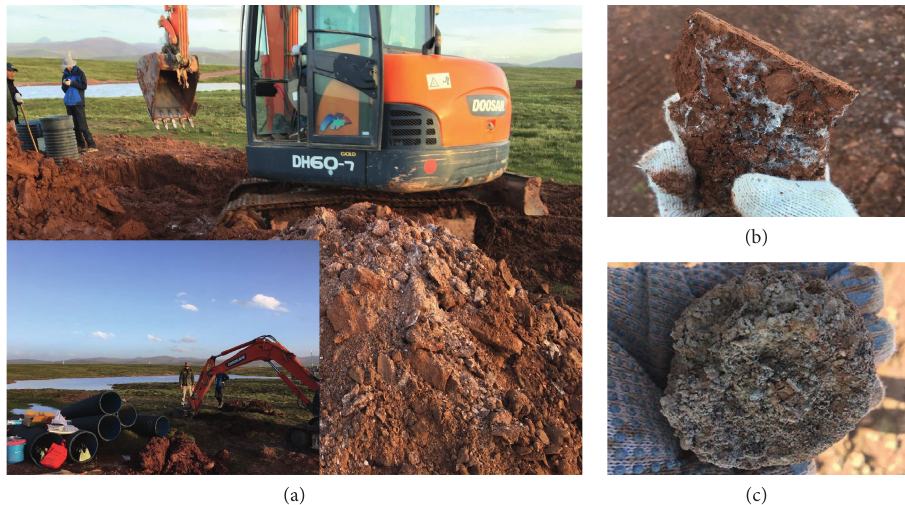
Figure 7: In situ test. (a) Construction site. (b) Pro-improved frozen soil. (c) Postimproved frozen